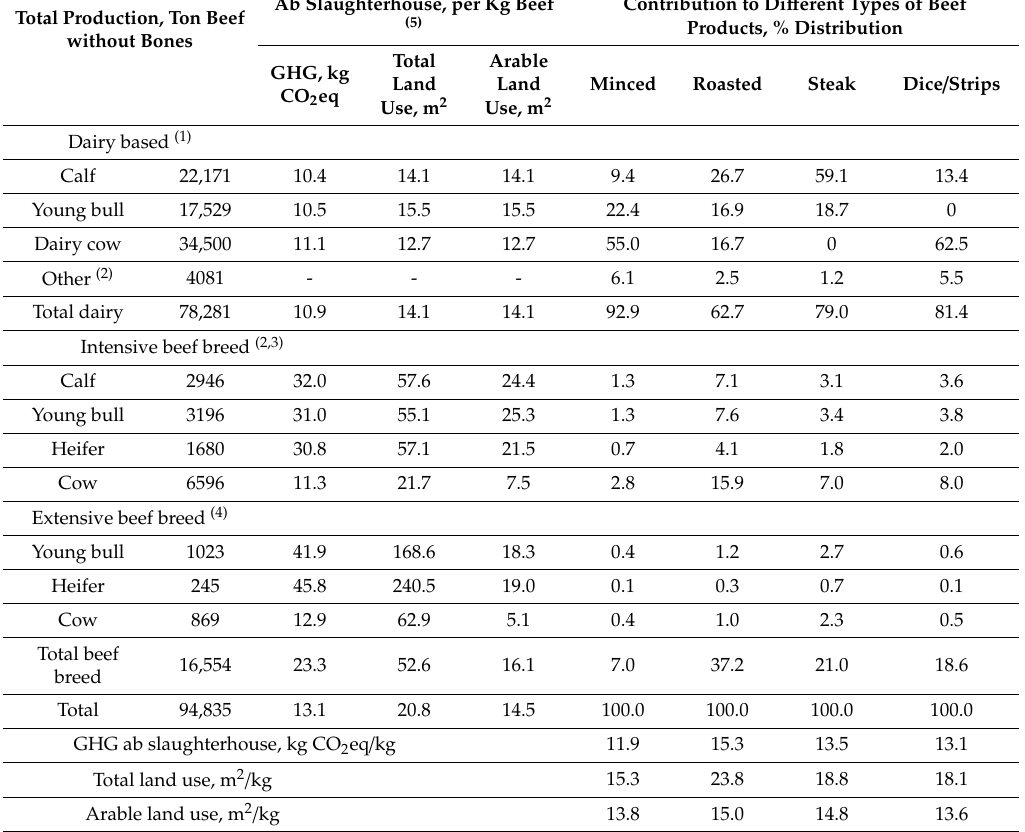
Table 1. Origin of di ff erent types of Danish-produced beef products, the related greenhouse gas (GHG) emission and land use estimated at the point of leaving the slaughterhouse and the contribution to di ff erent types of beef